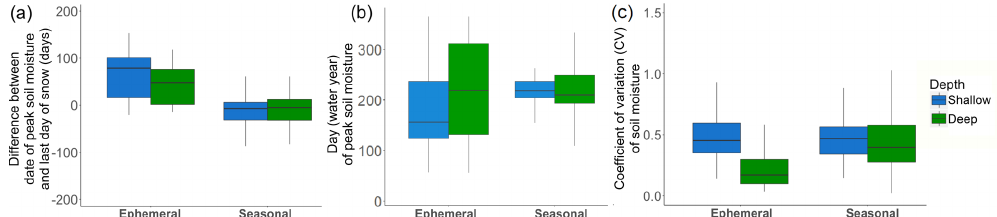
Figure 4. (a) The difference between date of peak soil moisture and last day of snow (days) for shallow (5cm) and deep (50cm) soil moisture during water years 2014–2016 in Great Basin SNOTEL stations with ephemeral snow (50 site years) and seasonal snow (278 site years). (b) Day of peak soil moisture for SNOTEL and SCAN stations for shallow (5cm) and deep (50cm) soil moisture during water years 2014–2016. (c) The coefficient of variation (CV) for shallow (5cm) and deep (50cm) soil moisture during water years